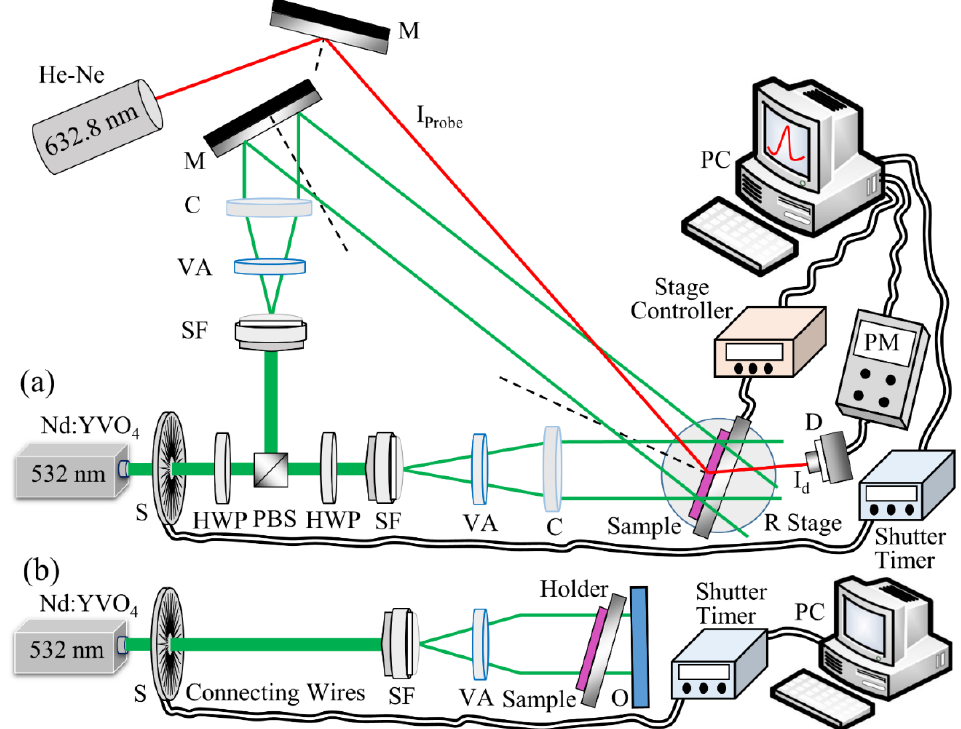
Figure 3. Experimental setups for recording ( a ) volume transmission holographic gratings and ( b ) Denisyuk reflection holographic gratings. Where S: electronic shutter; HWP: half wave plate; PBS: polarising beam splitter; SF: spatial filter; VA: variable aperture; C: collimator; M: mirror; PP: photopolymer; D: photodetector; PM: power metre; PC: computer; O: object.